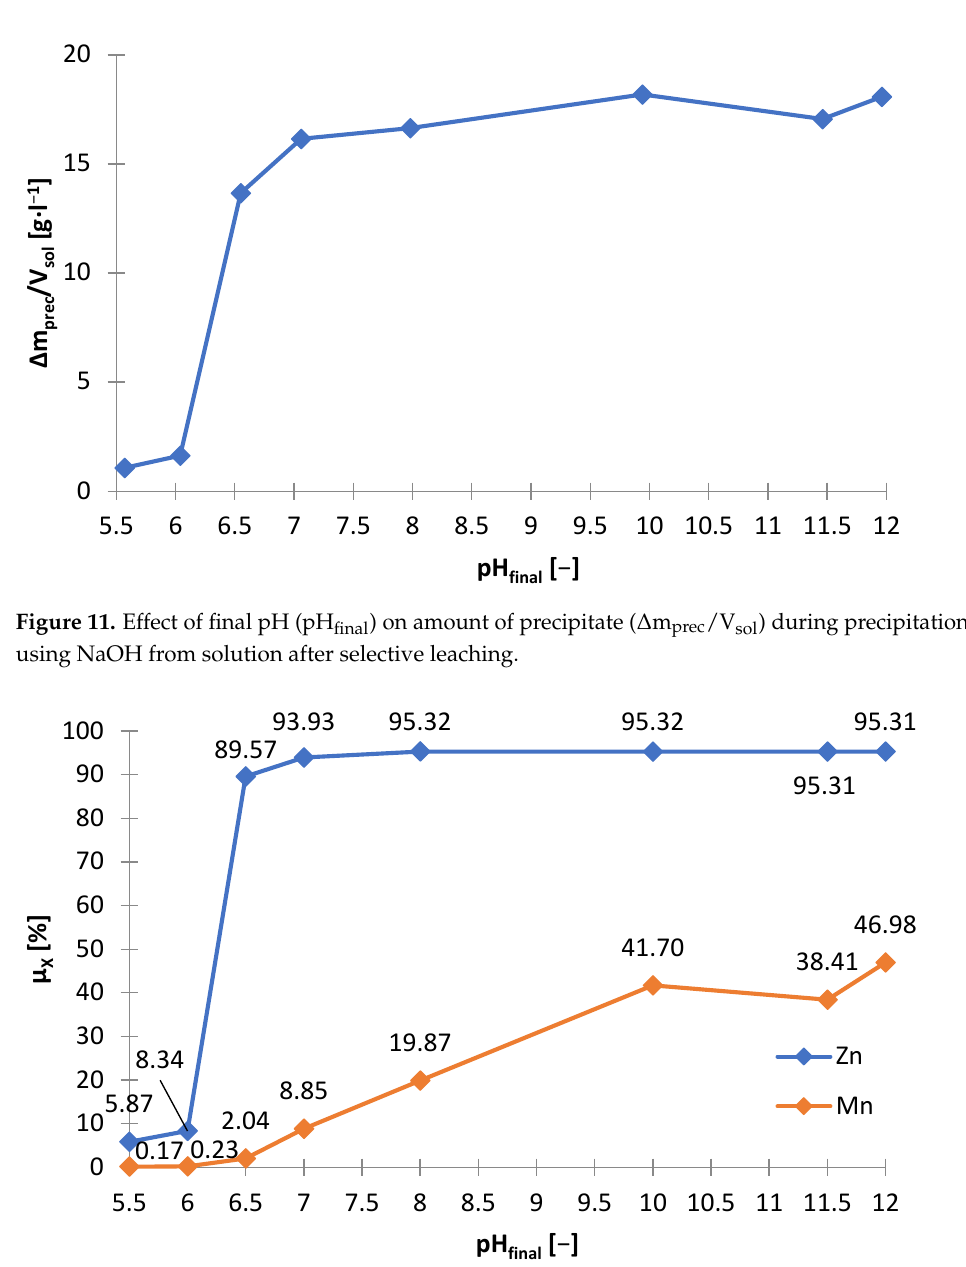
Figure 12. Effect of final pH (pH final ) on precipitation yield ( µ X ) of zinc and manganese during precipitation by using NaOH from solution after selective leaching.